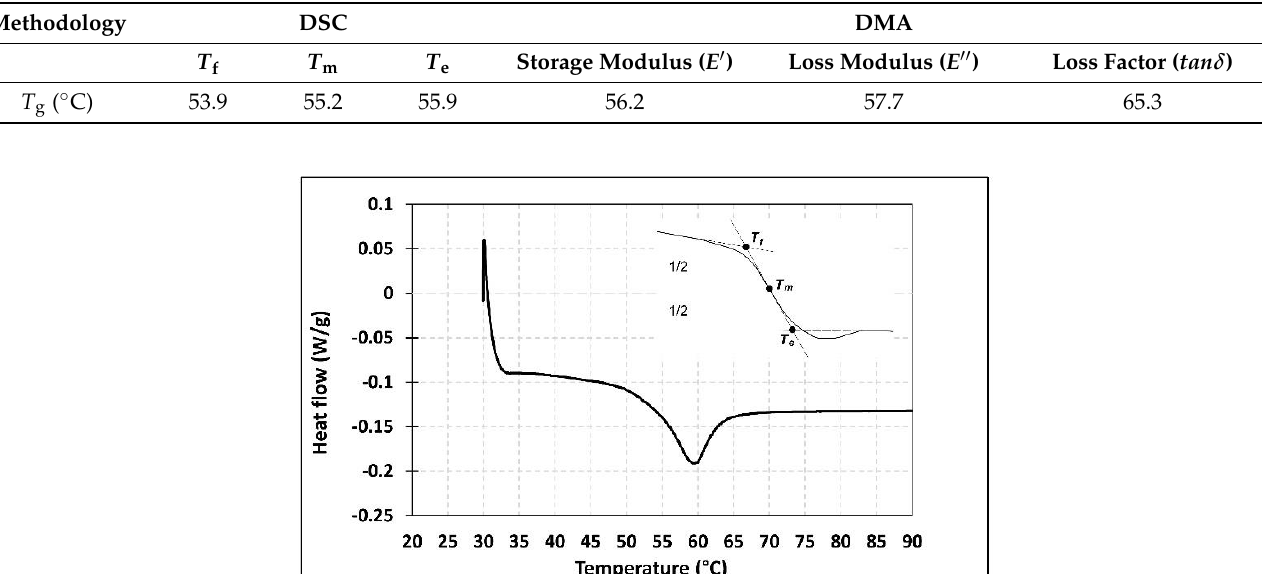
Figure 6. Dynamic mechanical analysis (DMA) test results. 3. Results and Discussion In this section, experimental results are presented and discussed in terms of load– deflection curve, failure mode, and strain distribution along the CFRP strips. Analytical predictions for the load–deflection relationship are also presented. In the analytical work, equilibrium of forces and moments is applied, where the fol- lowing assumptions have been considered: (i) strain compatibility; (ii) Bernoulli’s hypoth- esis; (iii) perfect bond, and (iv) the parabola–rectangle stress–strain curve defined in Eu- rocode 2 [20]. Based on this, theoretical moment–curvature is determined for uncracked and cracked sections and, finally, the moment–curvature relationship is derived as the interpolation between cracked and uncracked sections, according to CEB-FIP Model Code 1990 [54]. Afterwards, an analytical load–deflection curve is obtained from an integration of curvatures. It should be noted that shrinkage previous to loading has been found to affect the load–deflection behavior of RC members [55–58]. This influence has also been experienced in the NSM FRP-strengthened beams included in this work. Therefore, a sys- tematic procedure is applied to account for this effect in the analytical predictions for their load–deflection relationship. 3.1. Shrinkage Effects on Instantaneous Deflection of Concrete Beams Concrete shrinkage is a reduction in its volume due to moisture loss. This reduction starts after casting the concrete and depends on the water/cement ratio, ambient humidity, shape of aggregates, mixture properties, curing method and temperature, and geometry of specimens, among other parameters. In plain concrete without reinforcement, this